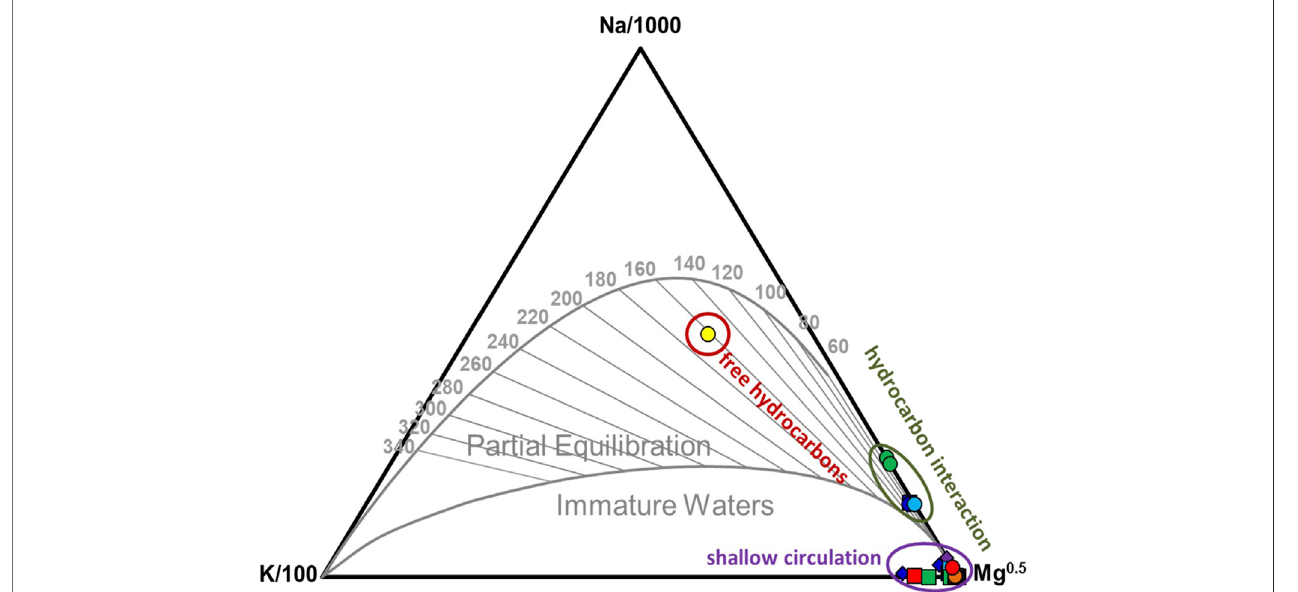
FIGURE 4 | Position of the sampled waters in the Giggenbach